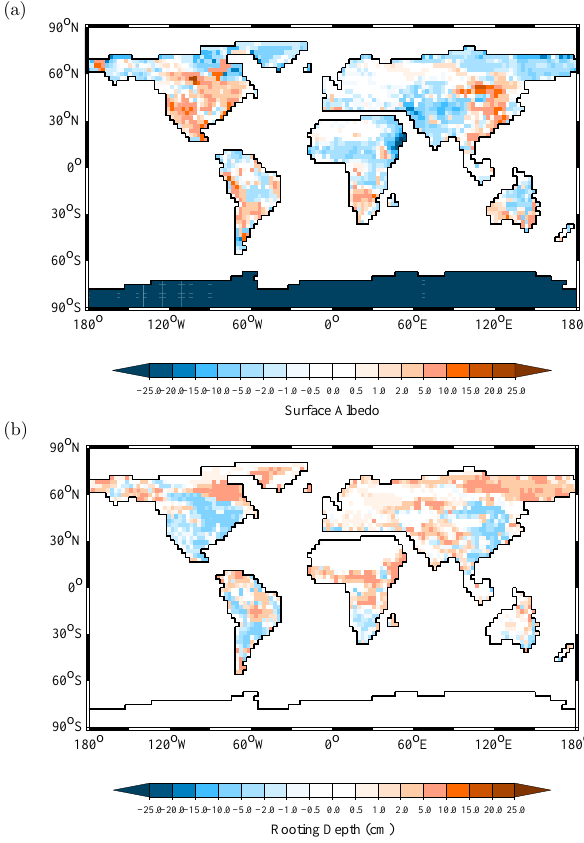
Fig. 19. (a) Surface albedo difference and (b) rooting depth differ- ence between experiment MM4-veg and